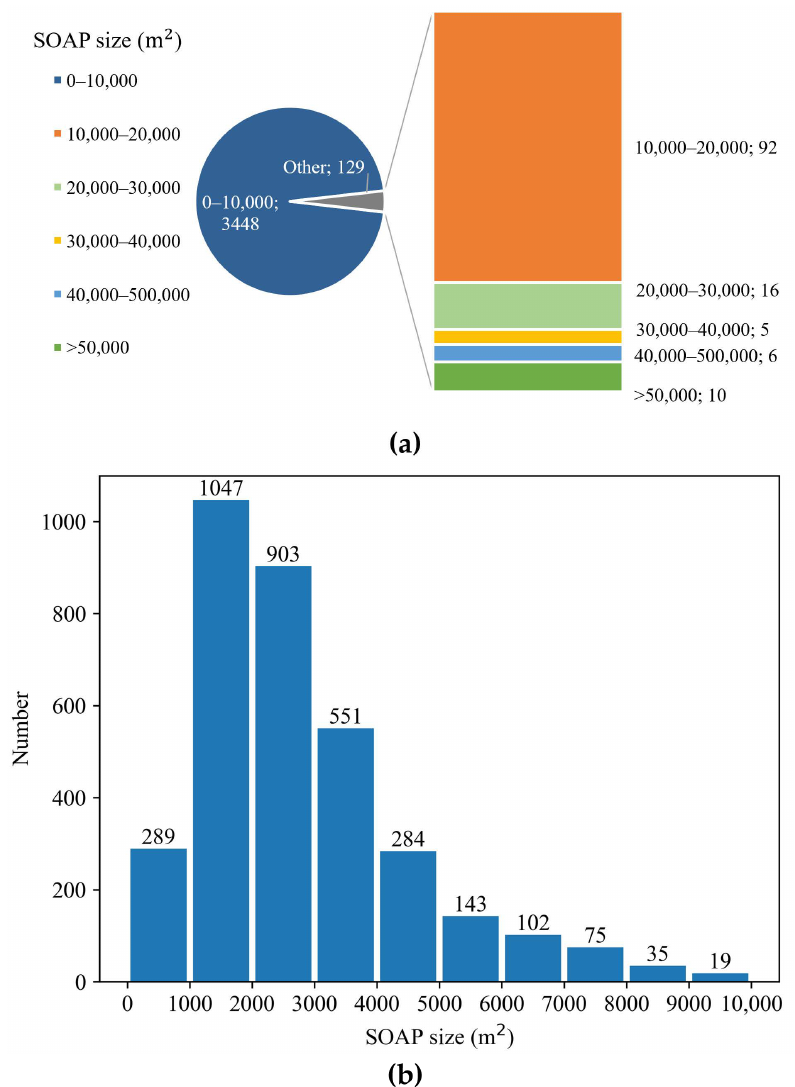
Figure 9. ( a ) Number of SOAPs in different areal ranges extracted in the study region and ( b ) histogram of the numerical distribution of SOAPs ranging in size from 0 to 10,000 m 2